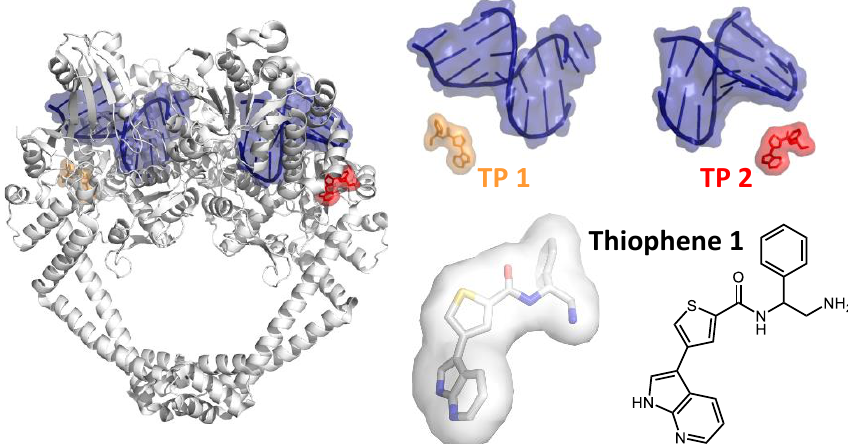
Figure 4. Allosteric inhibition. Left: Structure of a GyrBA fragment bound to DNA and two molecules of Thiophene 1 (orange, red) [35]. Thiophene 1 does not contact the DNA (blue) and inhibits DNA cleavage allosterically. Right: DNA and the position of the two Thiophene 1 molecules (TP 1, TP 2; top) and structure of Thiophene 1 in stick representation and chemical formula. PDB-ID: 5npk ( S. aureus GyrBA fragment with Thiophene 1).